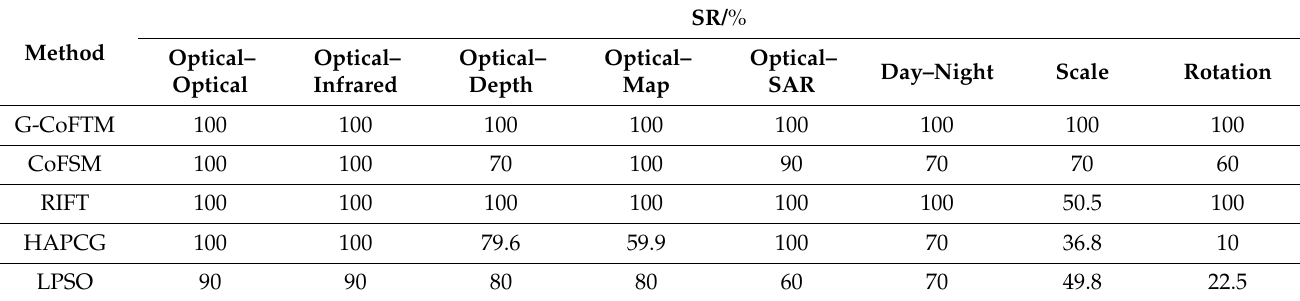
Table 5. Comparison on SR metric.